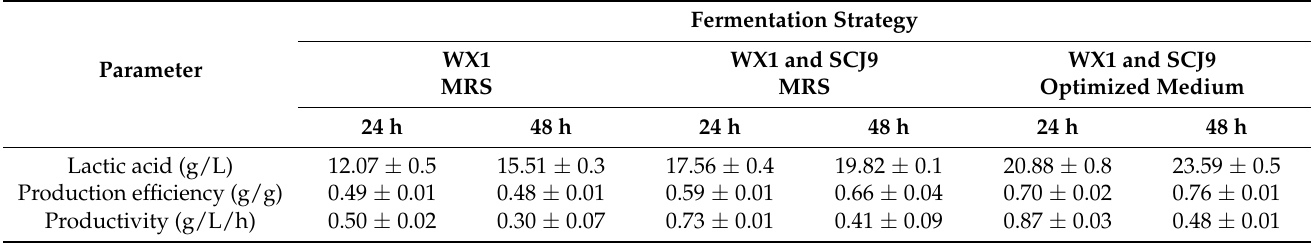
Table 6. Comparison of lactic acid titer, production efficiency and productivity of coculture E. mundtii WX1 and L. rhamnosus SCJ9 cultivated in optimized medium and MRS with 30 g/L mixed glucose-xylose carbon source in the presence of 2 g/L furfural at 37 ◦ C in comparing to the single